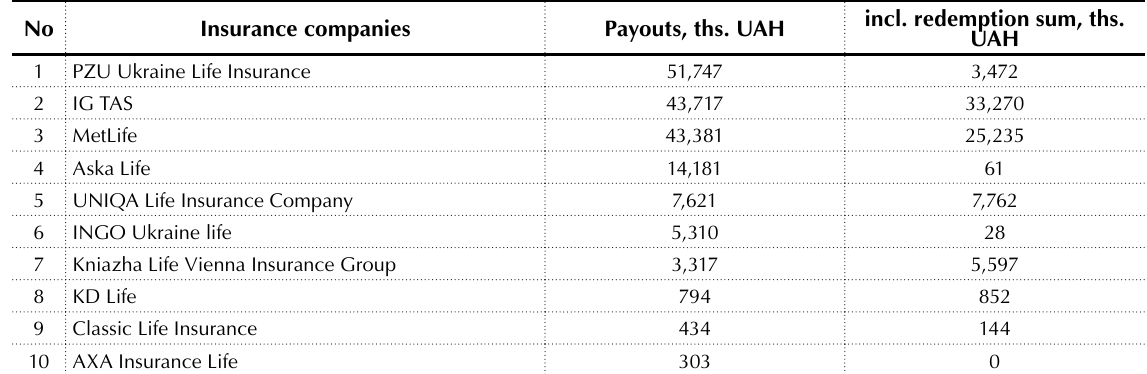
Table 4. TOP-10 largest life insurance companies by payouts for the 1st half of 2017 (ths.